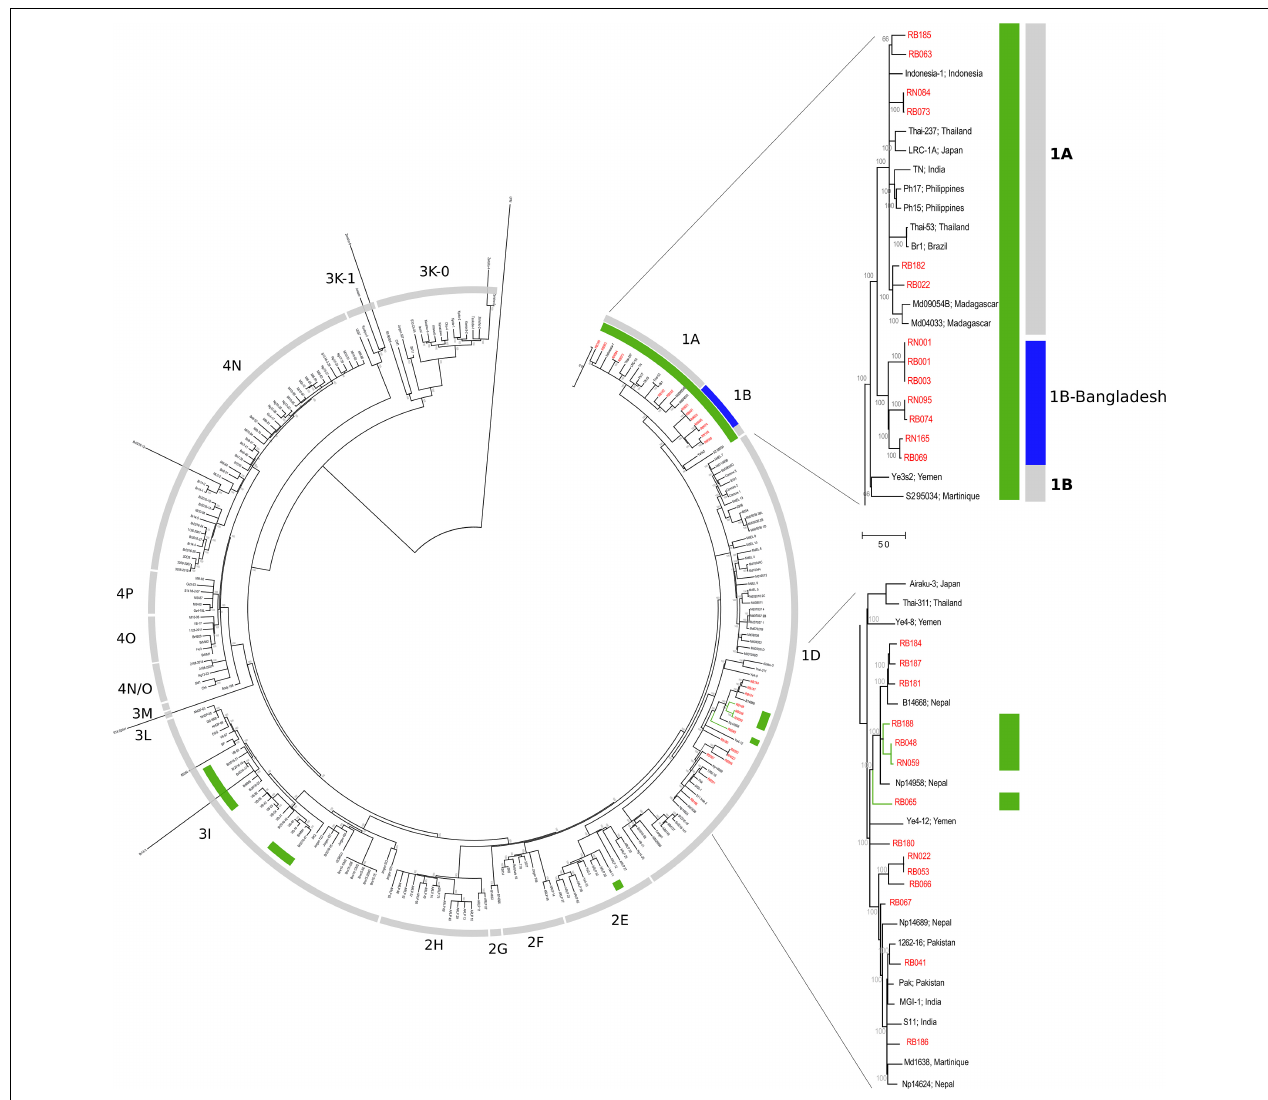
FIGURE 2 | Phylogeography of M. leprae strains. Maximum parsimony tree of 259 genomes of M. leprae built in MEGA 7. Support values were obtained by bootstrapping 500 replicates. Branch lengths are proportional to nucleotide substitutions. The tree is rooted using M. lepromatosis . The strains from Bangladesh are shown in red and their exact organization in the tree is shown in the two zoomed sections of the genotypes 1A-B and 1D. Strains with an A at SNP61425 in the esxA gene are shown in green. The specific 1B-Bangladesh genotype/cluster of Bangladesh strains is shown in